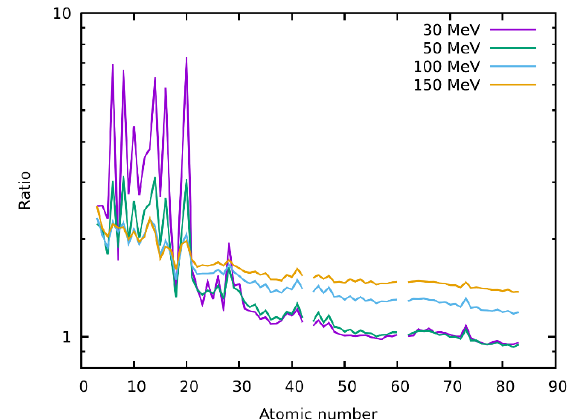
Figure 6: Neutron yield for protons and deuterons as a function of the target element expressed as the deuteron/proton neutron yield